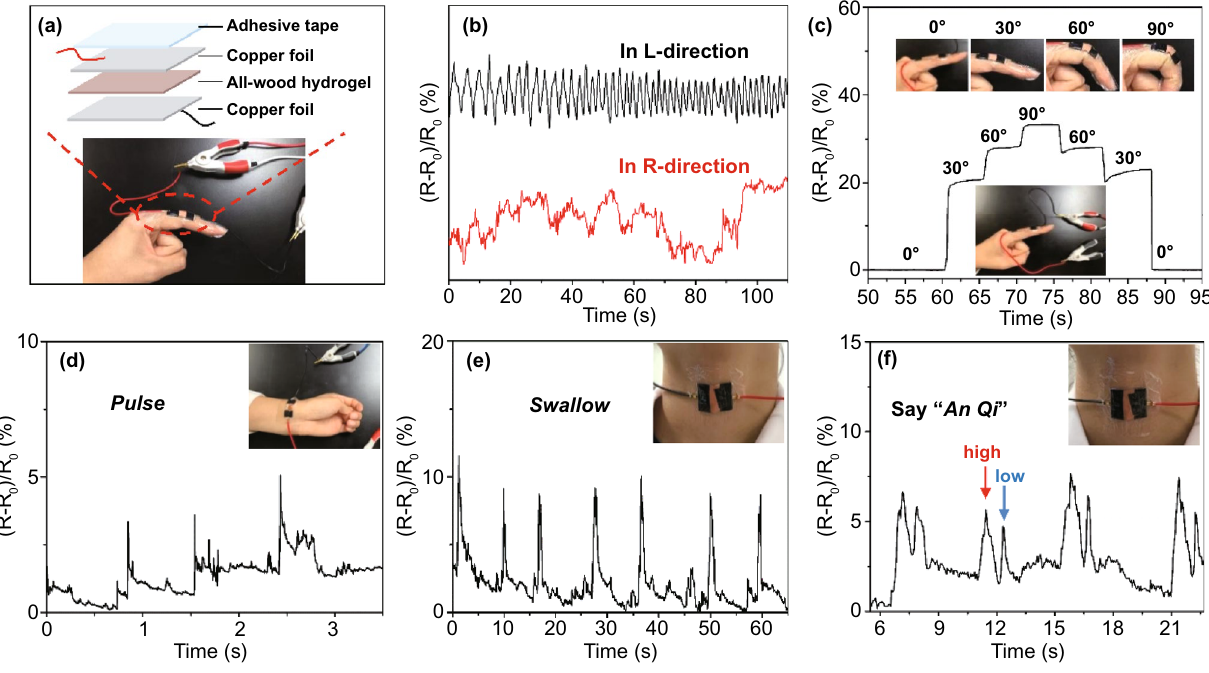
Fig. 6 Signal change of all-wood hydrogel (with 8.7 wt% lignin, 10% PVA, 4 days for salting in sodium sulfate solution at room tempera- ture) for real-time monitoring of various human motions. a Assembly process of the all-wood hydrogel sensor. b Real-time signal changes (( R − R 0 )/ R 0 ) of all-wood hydrogels bent repeatedly in the longitudinal and radial directions. The hydrogel can be used to monitor subtle muscle movements in real time, such as c finger flexion, d pulse beats, e swallowing, and f throat vibrations, as when a person says “An Qi” four times in a